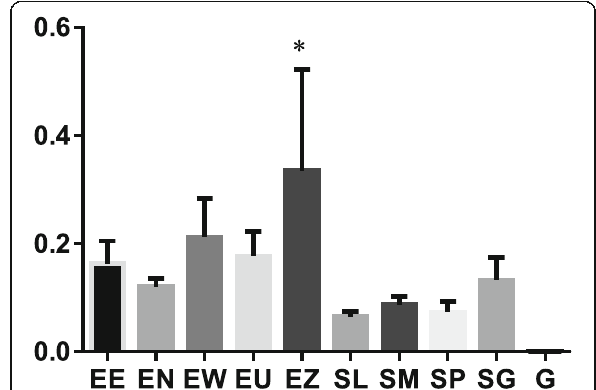
Fig. 2 The mean MIC in mg/ml of the acetone leaf extracts of the nine plants against six different bacterial species. EE = Eugenia erythrophylla , EN = Eugenia natalitia , EW = Eugenia woodii , EU = Eugenia umtamvunensis , EZ = Eugenia zeyheri , SL = Syzygium legatii , SM = Syzygium masukuense , SP = Syzygium sp., SG = Syzygium gerrardii , G = Gentamicin (positive control). The negative control (acetone) was higher than 25% (higher than 198 mg/ml). * = shows statistical significant differences ( p < 0.05) between Gentamicin and Eugenia